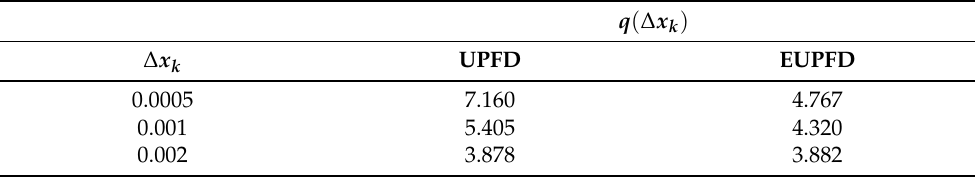
Table 6. Convergence rates for the nonlinear diffusion reaction equation by the UPFD and EUPFD with respect to ∆ x and a fixed ∆ t = 0.025.